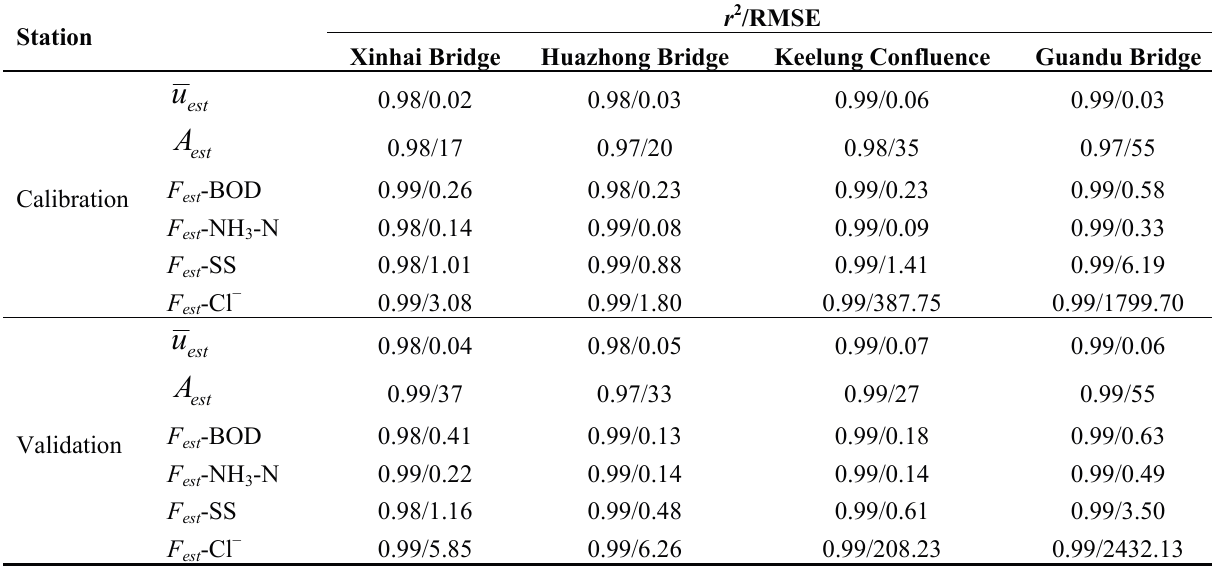
Table 2. Summary description of R-square ( r 2 ) and root mean squared error (RMSE).